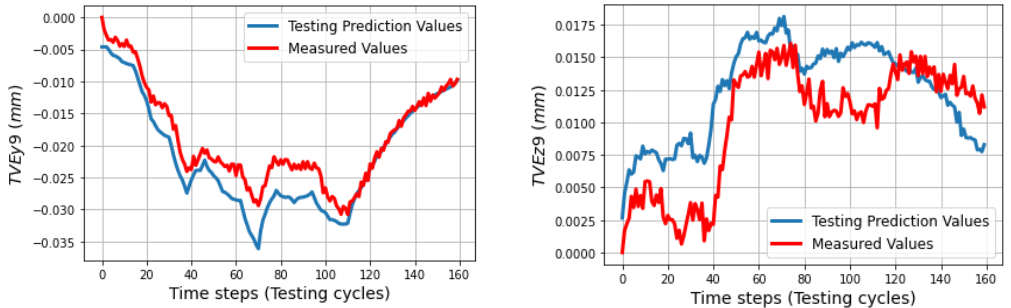
Figure 15. Prediction of TVEz6 and TVEx9 in the short process (SP) (1 cycle = 15 min).